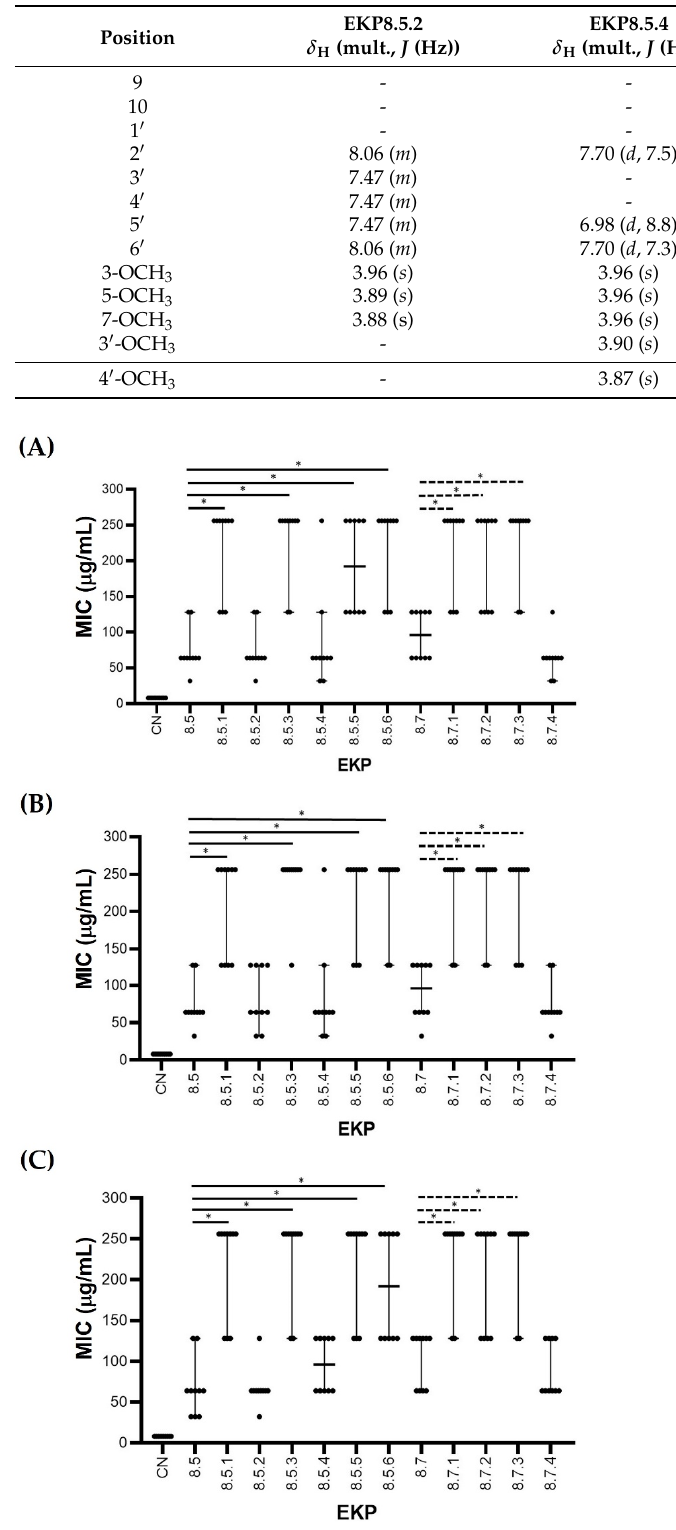
Figure 3. Scatter dot plot showing median values with 95% CI of minimal inhibitory concentration ( n = 10) of each EKP purified extract compared with EKP8.5 and EKP8.7, which were separately tested with CRKP ( A ), CRPA ( B ), and CRAB ( C ). Gentamicin (CN) was tested as the positive control. *, Significant difference apart from EKP8.5 and EKP8.7 at p ≤ 0.05.